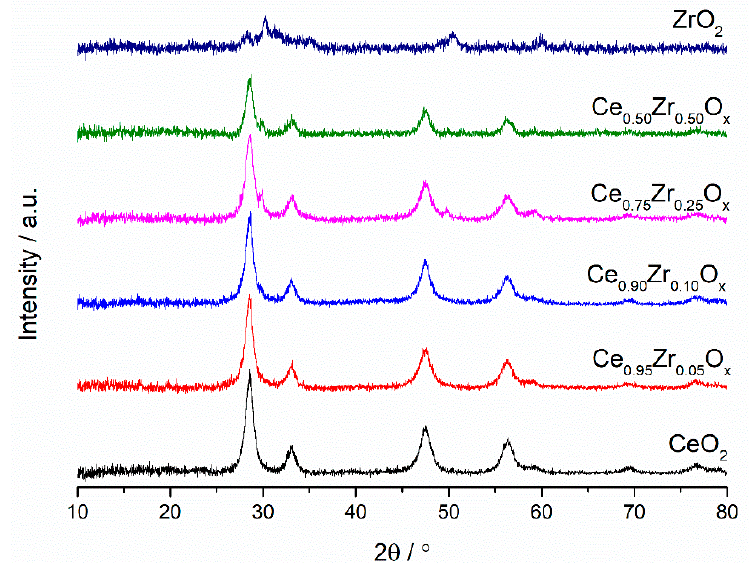
Figure 3. Powder XRD patterns of the ceria–zirconia mixed metal oxide catalysts prepared from carbonate precursors.